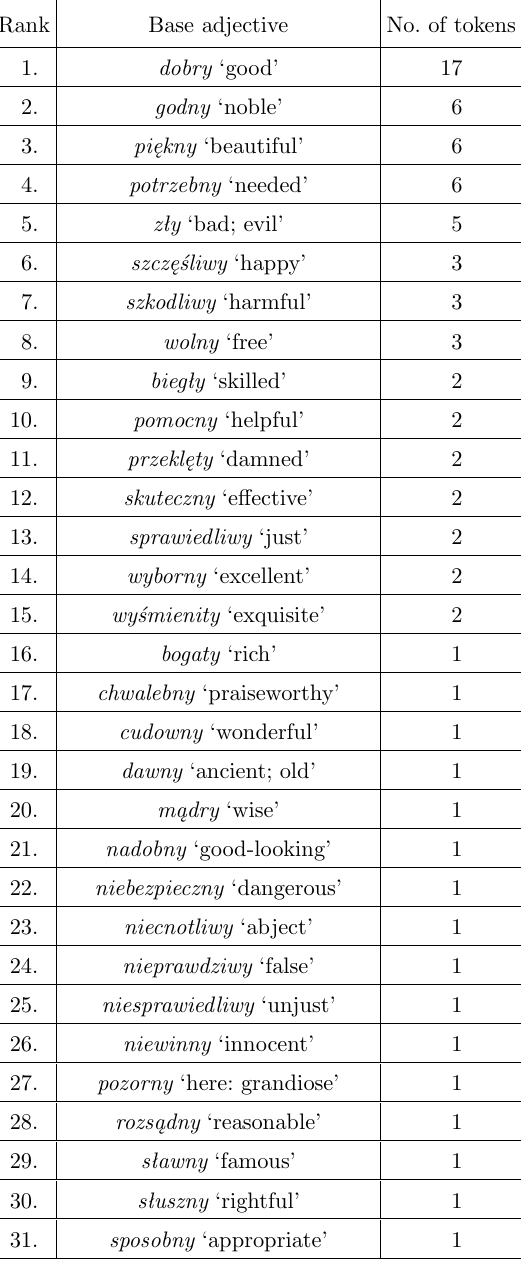
Adjectival bases reinforced by arcy - in the